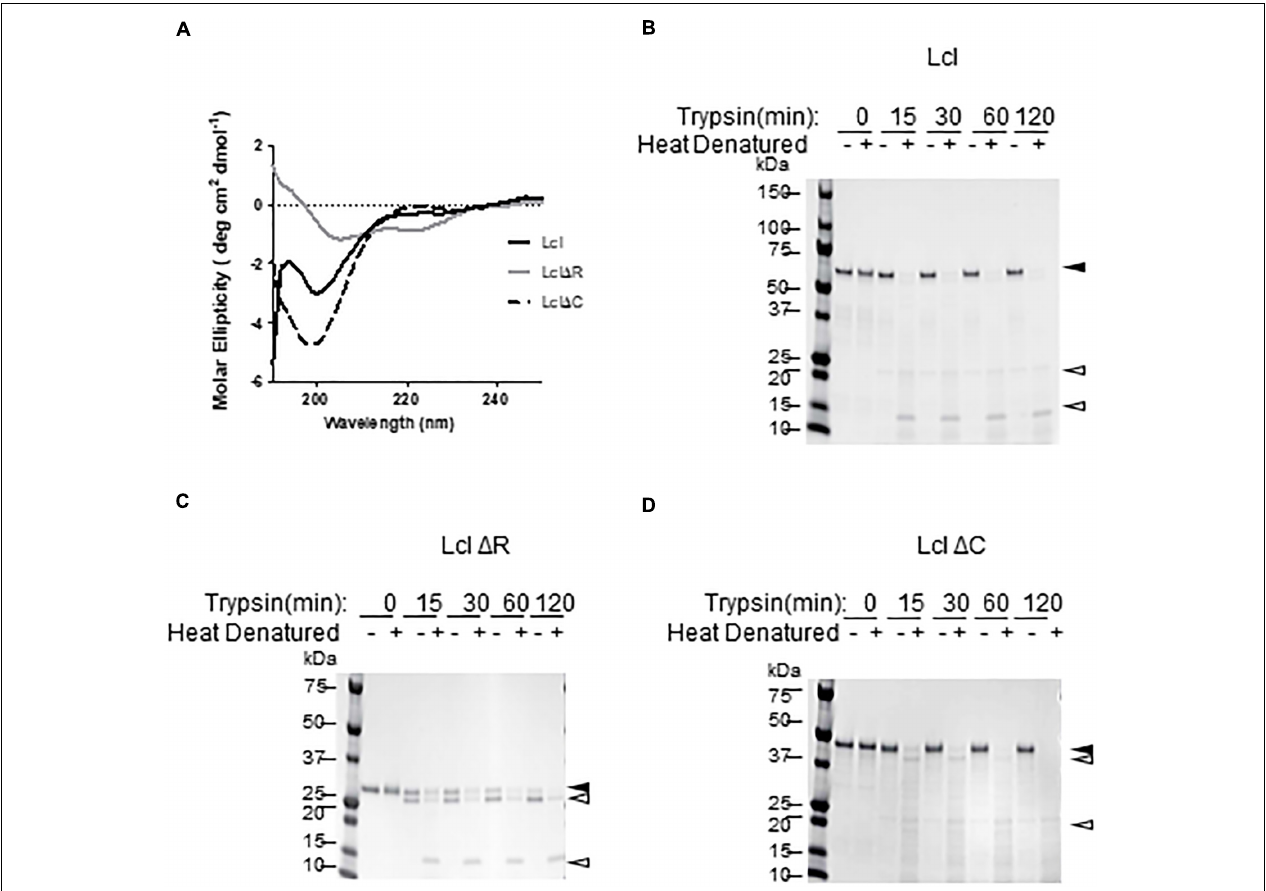
FIGURE 1 | Lcl forms collagenous triple helix structures. (A) Circular dichroism profiles of full length His-tagged Lcl (Lcl), His-tagged Lcl lacking the C-terminal domain (Lcl (cid:49) C) and His-tagged Lcl lacking the collagenous repeat domain (Lcl (cid:49) R). (B–D) Coomassie stained gels of purified His-tagged Lcl (B) , His-tagged Lcl (cid:49) R (C) , and His-tagged Lcl (cid:49) C (D) after incubation with trypsin for the indicated time points with or without heat denaturing at 95 ◦ C for 10 min. Black arrowheads with labels indicated the full-length proteins and open arrowheads denote digestion